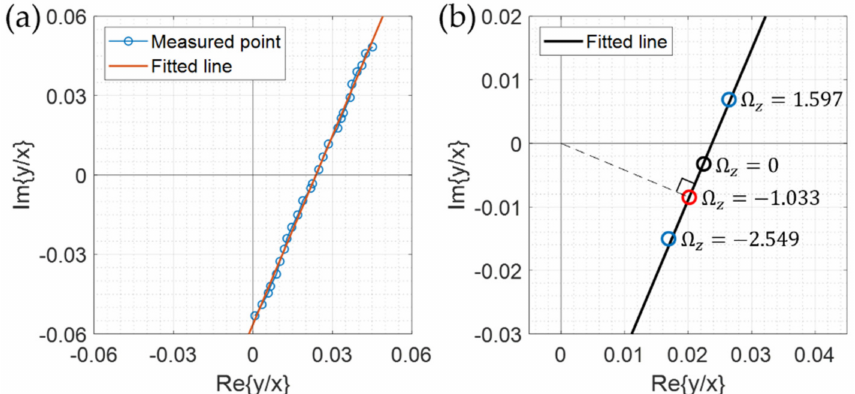
Figure 8. The experimental results: ( a ) the plot of amplitude ratios y/x of Equation (20) measured with various angular rates, and ( b ) the fitted straight line characterizing the resonator. From the fitting with a straight line, the 4 real constants characterizing the resonator are extracted as B = 0.318, θ = − 22.84 ◦ , a = 1.033 ◦ /s, and b = 3.944 ◦